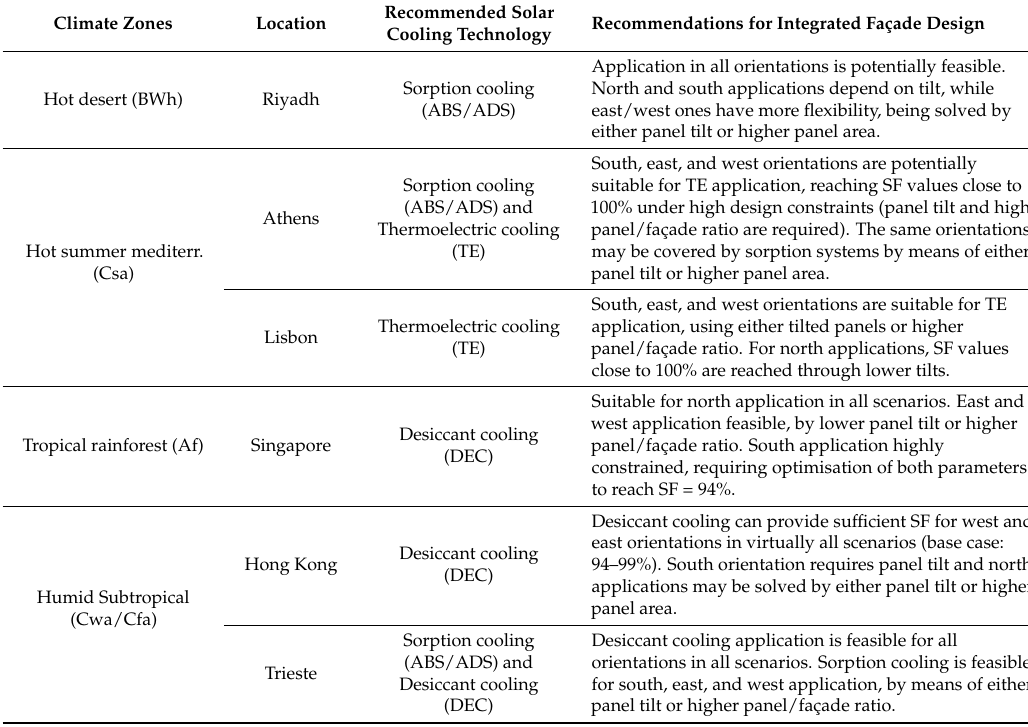
Table 10. Recommendations for further development of integrated façade concepts in each assessed location/climate